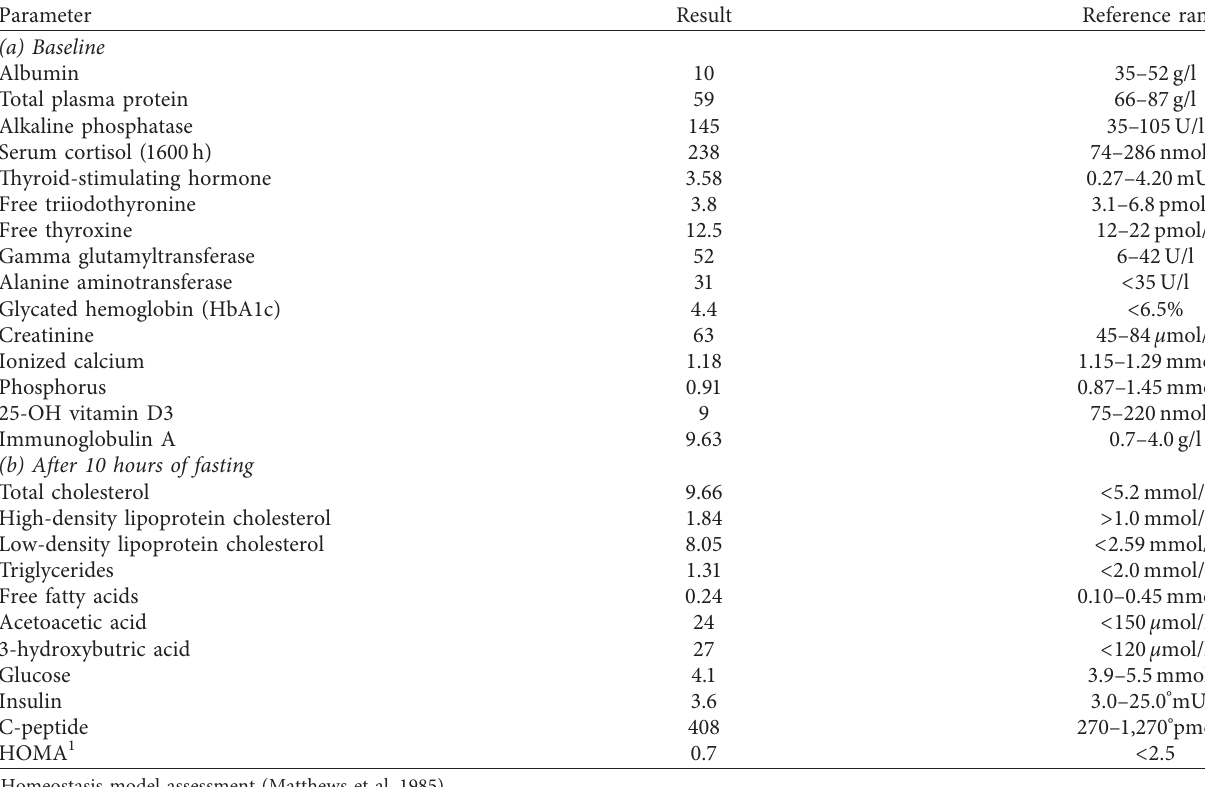
Table 1: Biochemical parameters.